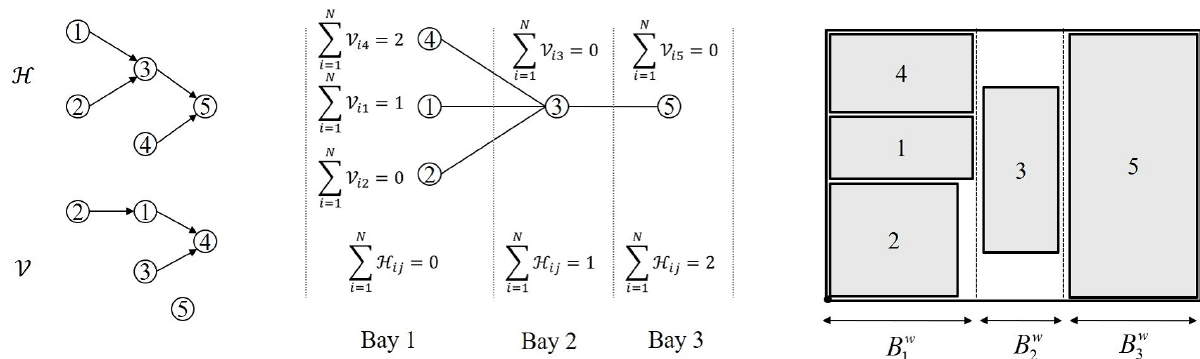
Figure 1. Example illustrating the bay assignment (shown at center) and the obtained layout (shown at right) from the horizontal and vertical relative-positioning graphs (shown at left).